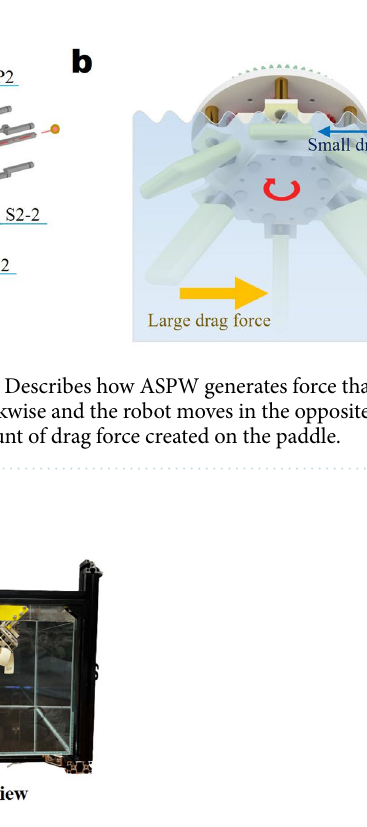
Figure 3. ( a ) Top view and the ASPW thrust force measurement method using a load cell. ( b ) Side